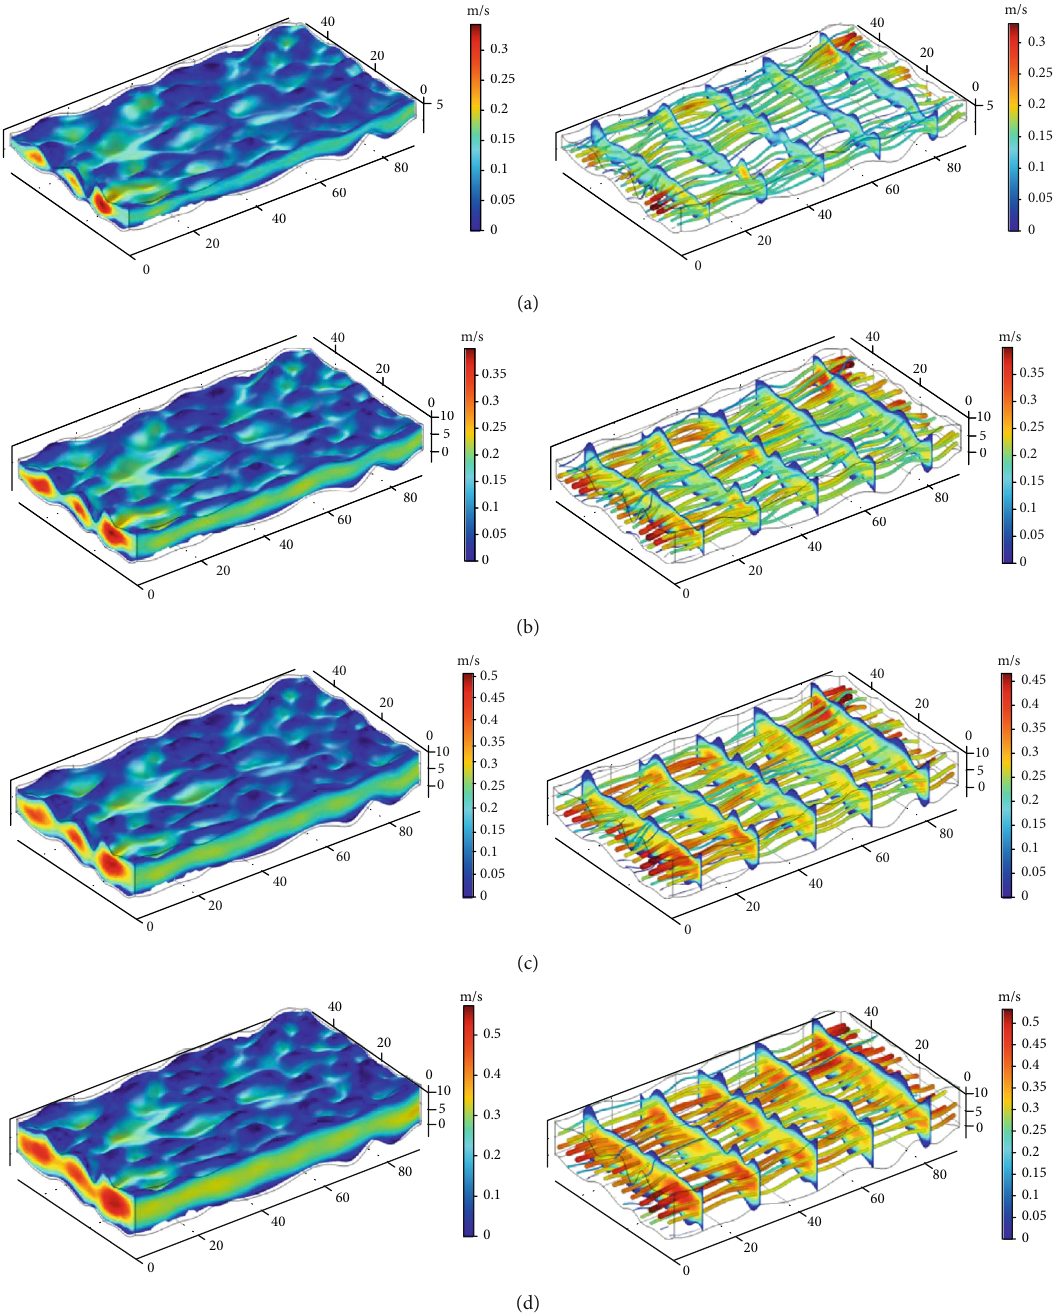
Figure 11: Velocity and streamline distribution of various fracture apertures. (a) e = 6 mm . (b) e = 8mm . (c) e = 10 mm . (d) e = 12 mm